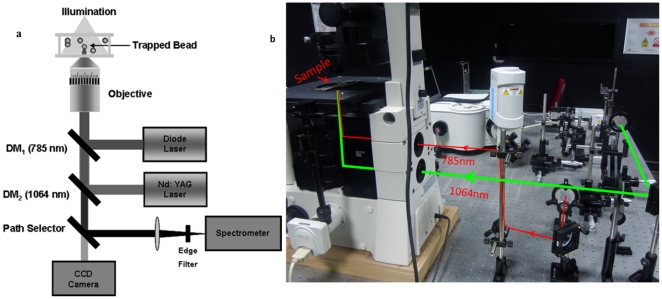
The experimental apparatus used in the present studies.(a) Schematic representation of the Raman Tweezers set-up. (b) Picture of the Raman Tweezers set-up showing the geometry of the trapping laser beam and the Raman probe laser beam.